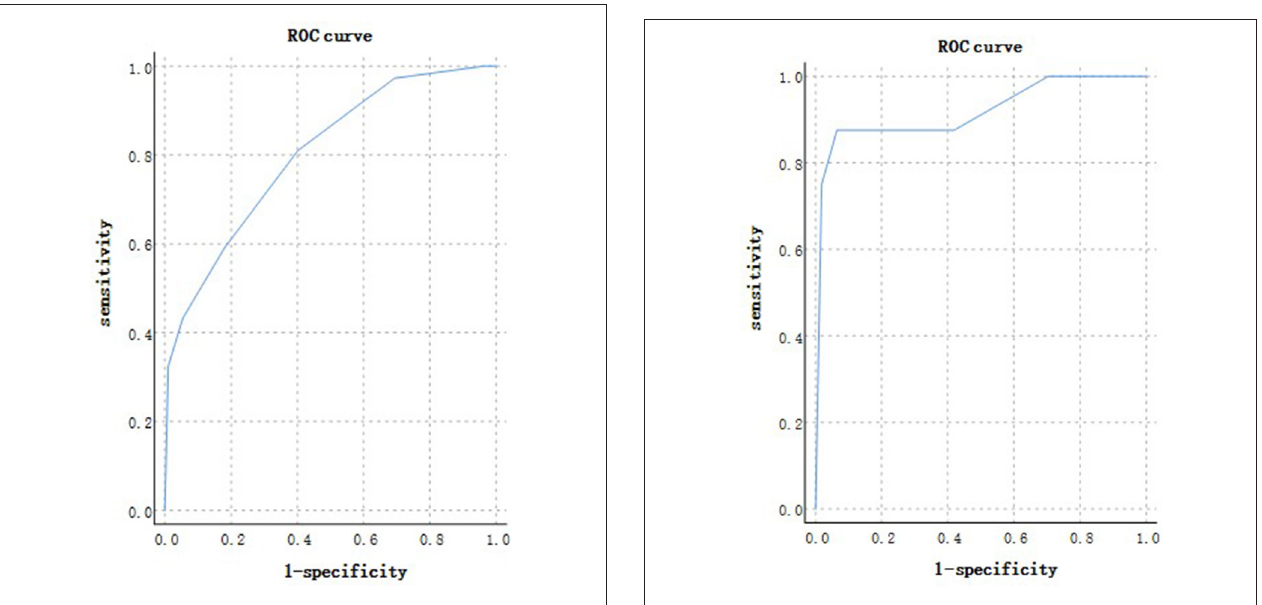
TABLE 10 | The performance of various methods for distinguishing between the severe cases and the non-severe patients( n = 718). Variables